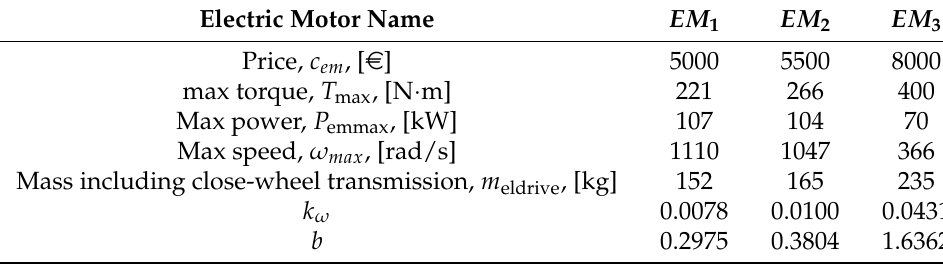
Table A4. Electric motors